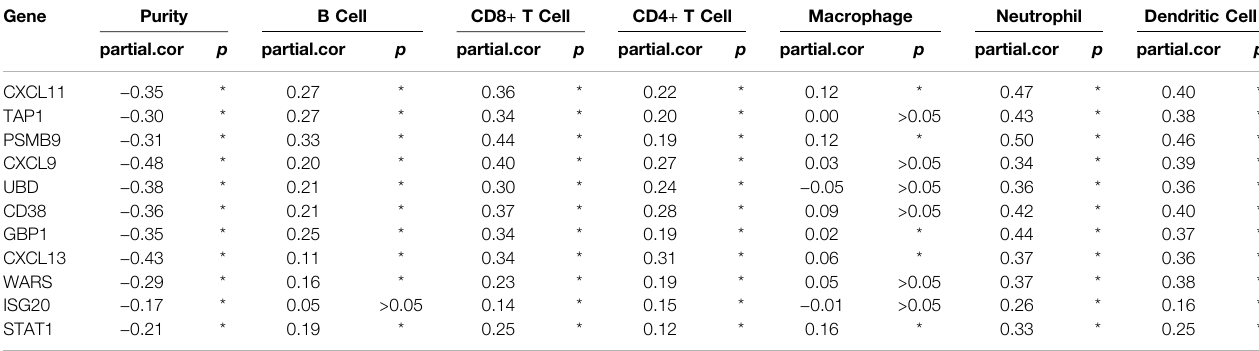
TABLE 3 | The correlation between prognosis-related DEGs and immune cell in fi ltration. Gene Purity B Cell CD8 + T Cell CD4 + T Cell Macrophage Neutrophil Dendritic Cell partial.cor p partial.cor p partial.cor p partial.cor partial.cor